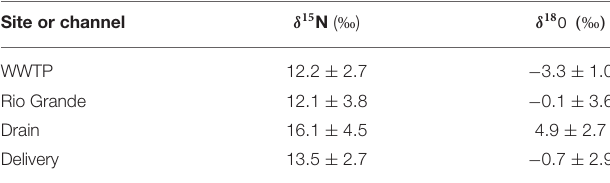
TABLE 2 | Average isotope values for the channels with ± one standard